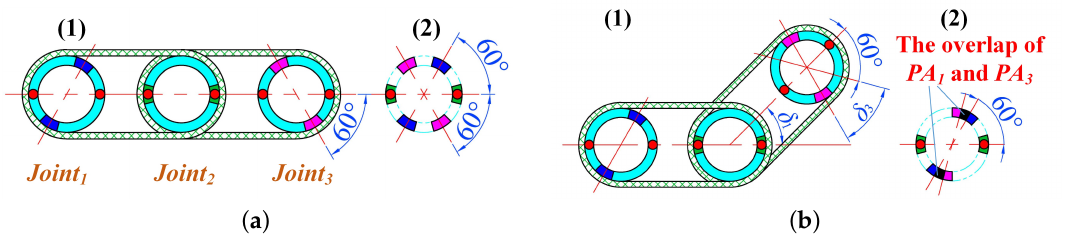
Figure 15. The phase difference for the SJC 3 after the Joint 2 is rotated δ 1 . ( a ) The iniational status of three joints. ( b ) The work areas of the Joint 1 and Joint 3 will be driven at the same time. The work areas of the Joint 1 and Joint 3 overlap. If the switch motor driving the cams makes the PA 1 contact the F 1 , then PA 3 may contact the F 3 at the same time. So the Joint 1 and Joint 3 will be driven at the same